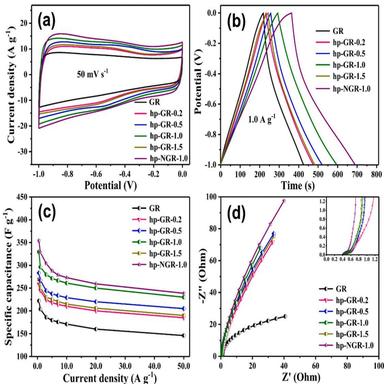
CV curves (a), GCD curves (b), rate capabilities (c) and Nyquist plots (d) of the as-prepared materials in the three-electrode system.